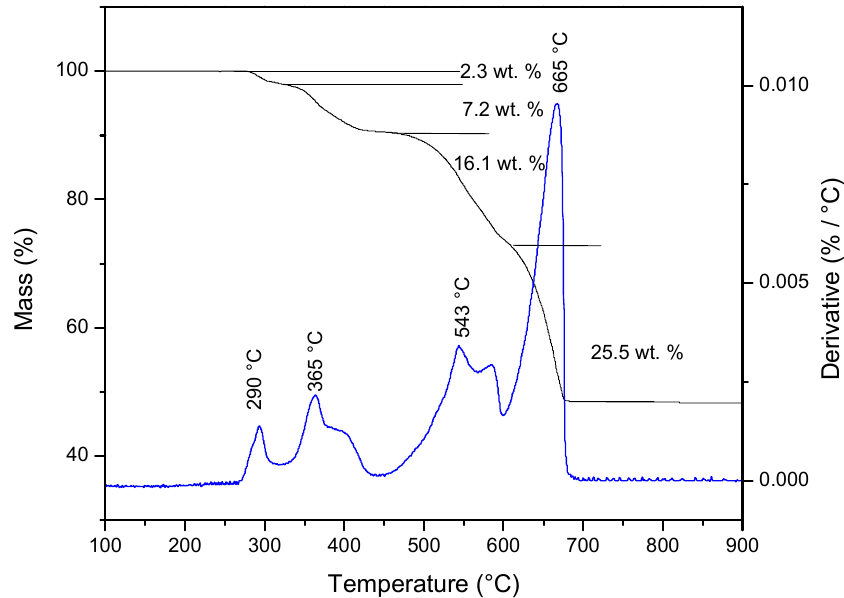
Figure 3. Thermogravimetric and derivative thermogravimetric analysis of Hg ‐ jarosite.